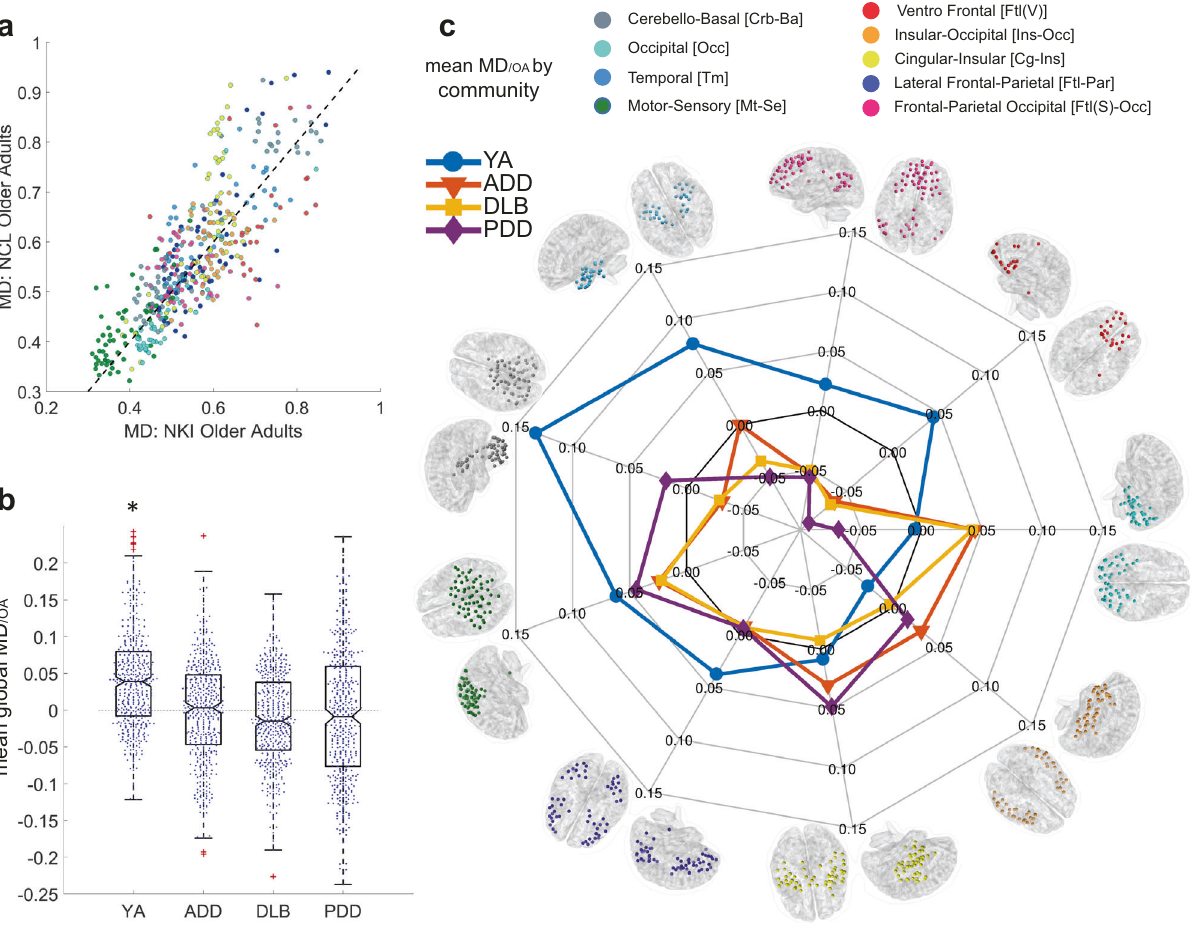
Fig. 8 Modular dissociation relative to older adults, MD/OA; changes from healthy ageing to dementia. a Scatter plot with MD values from the OA groups within the Nathan Kline Institute (NKI) and the Newcastle University (NCL) cohorts; colours are shown according to communities. Both OA groups were correlated; Pearson r = 0.8, p -value = 1.17e – 102, R 2 = 0.64. b Global MD /OA for the NKI-young adult (YA) group and the NCL groups; Alzheimer ’ s disease dementia (ADD), dementia with Lewy bodies (DLB), and Parkinson ’ s disease dementia (PDD). *Statistically different from zero, Wilcoxon signed- rank test: p -value = 1.183e – 29. The mean values and standard deviations are derived from the whole brain across the nodes. c Spider plot for Mean MD /OA by the community. Ageing drives a signi fi cant decrease of MD shown by the high scores in the YA group (blue line) and mainly for the cerebello-basal community, suggesting that the ageing brain moves towards a local connectivity regime of segregation. Neurodegenerative dementia did not change the overall brain ’ s MD /OA, but alterations are present in different communities. See Supplementary Fig 4 for non-referenced results of MD values and box